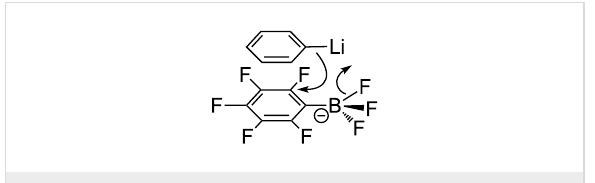
Scheme 10: Interaction between C 6 F 5 BF 3 − and